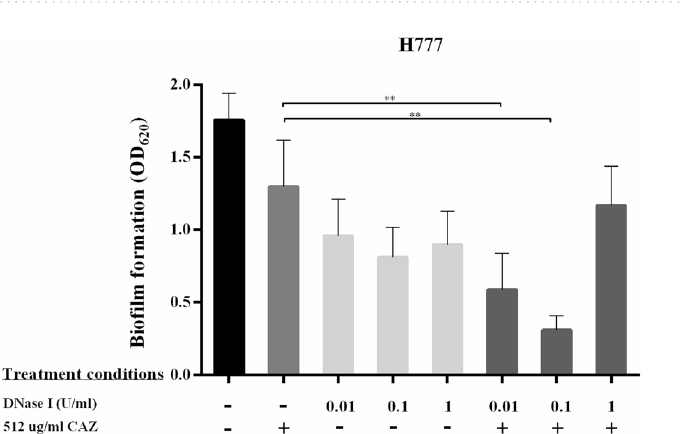
Figure 6. Combination of DNase I with CS/CAZ improved killing efficiency against shedding planktonic and biofilm cells of B. pseudomallei H777. Burkholderia pseudomallei H777 biofilm growth on pegs was untreated or treated with 0.01 U/mL DNase I alone for 24 h followed by addition of CS/CAZ (various concentrations) for another 24 h. The number of shed planktonic cells in the supernatant ( a ) and of biofilm cells on pegs liberated by sonication ( b ) were enumerated. The experiment was performed in duplicate in each of three independent experiments. Statistical significance was calculated using one-way ANOVA. Asterisks indicate statistical significance as follows: * p < 0.05 and ** p < 0.001.